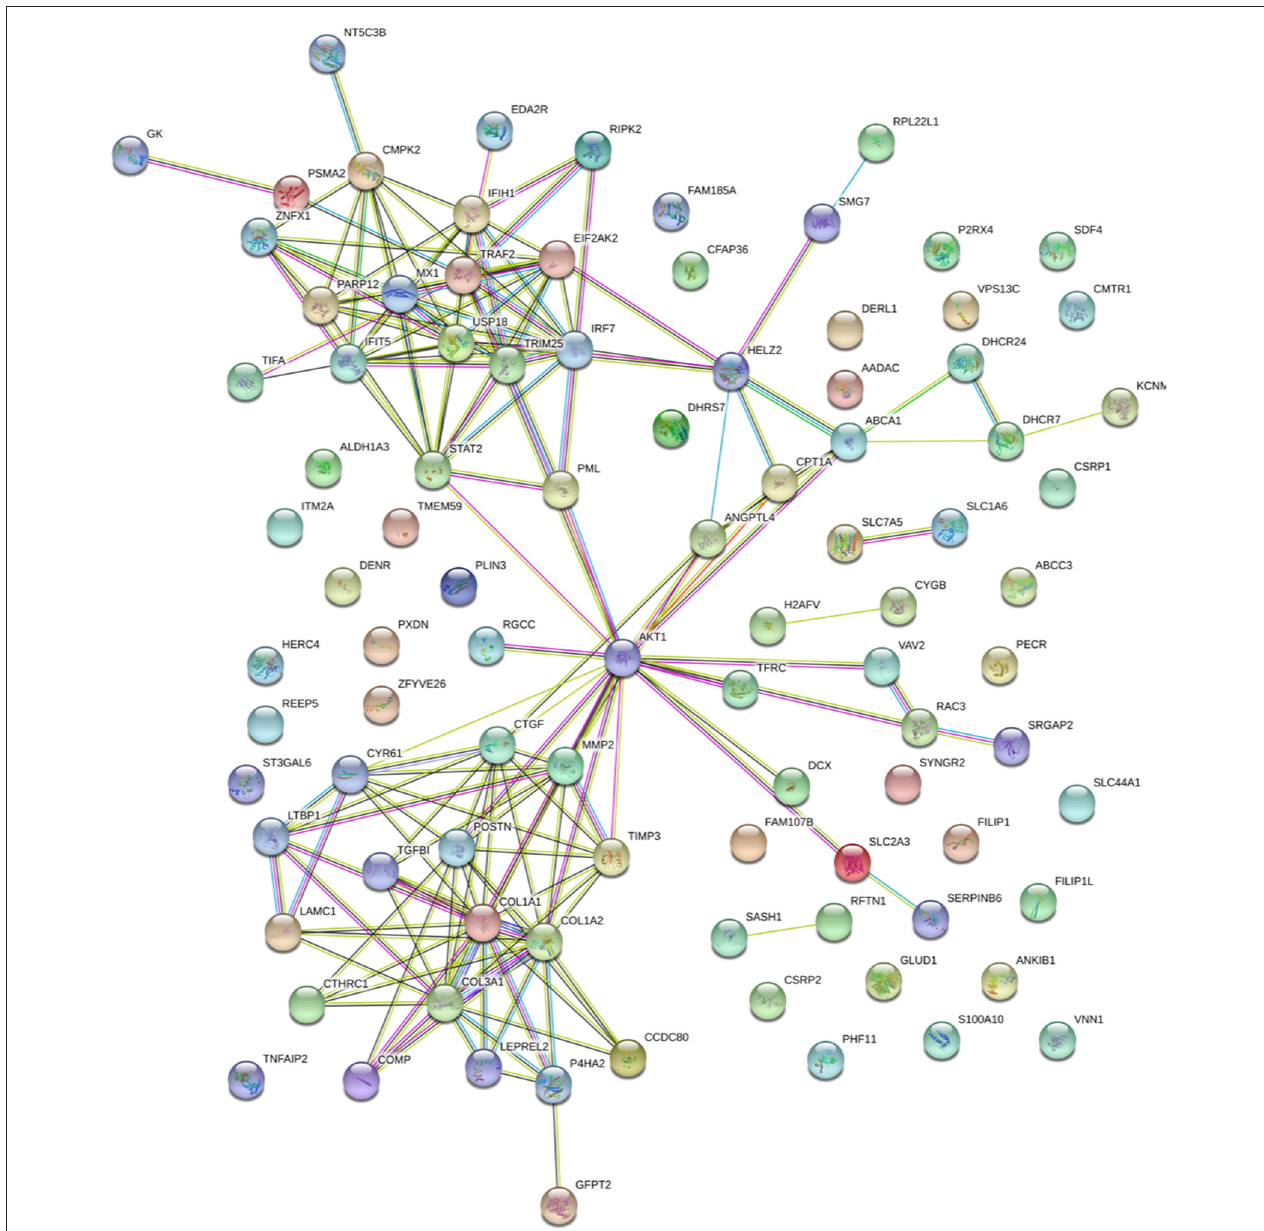
FIGURE 6 | Specific network analysis of proteins significantly altered in both RM/R and RM/M. The network of DAPs with STRING analysis. Each node represents a protein in the graph, each line represents the interaction between proteins, and the wider the line, the closer the relationship. REV-infected CEF cells; M, MDV-infected CEF cells; RM, REV and MDV coinfected CEF cells. DAPs, differentially accumulated proteins; REV, reticuloendotheliosis virus; CEF, chicken embryo fibroblast; MDV, Marek’s disease virus.